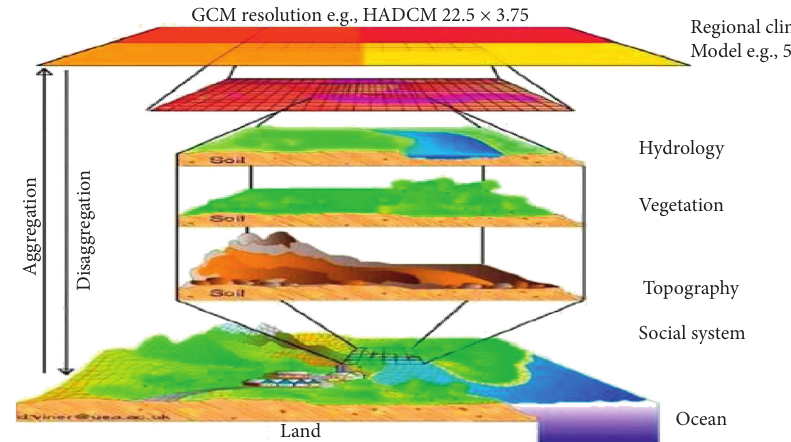
Figure 1: The concept of decreasing spatially (redrawn from